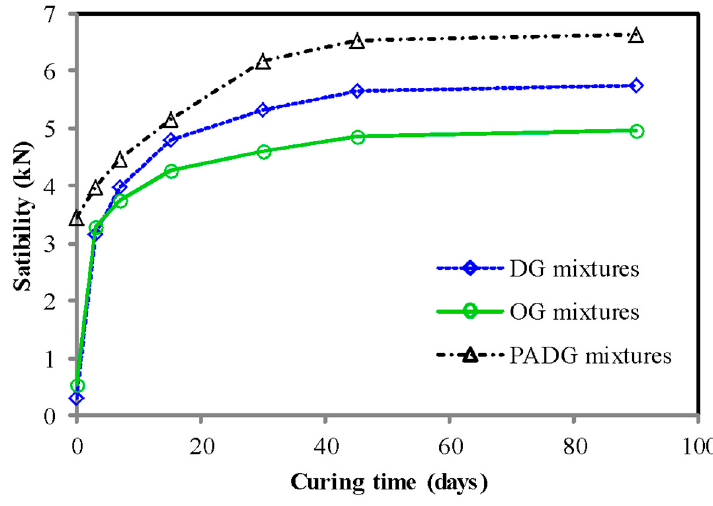
Figure 10. Stability of cold mixtures at different cured times at (25 °C).